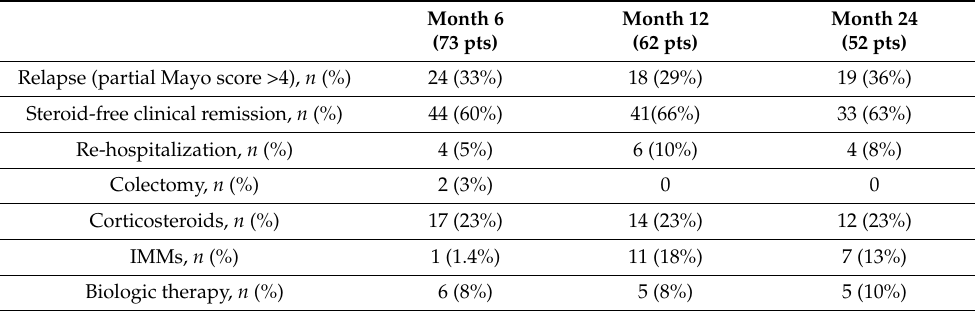
Table 3. Outcome measures of 88 patients with severe ulcerative colitis responding to intravenous corticosteroids during the first 2 years after discharge. IMMs = immunosuppressors.